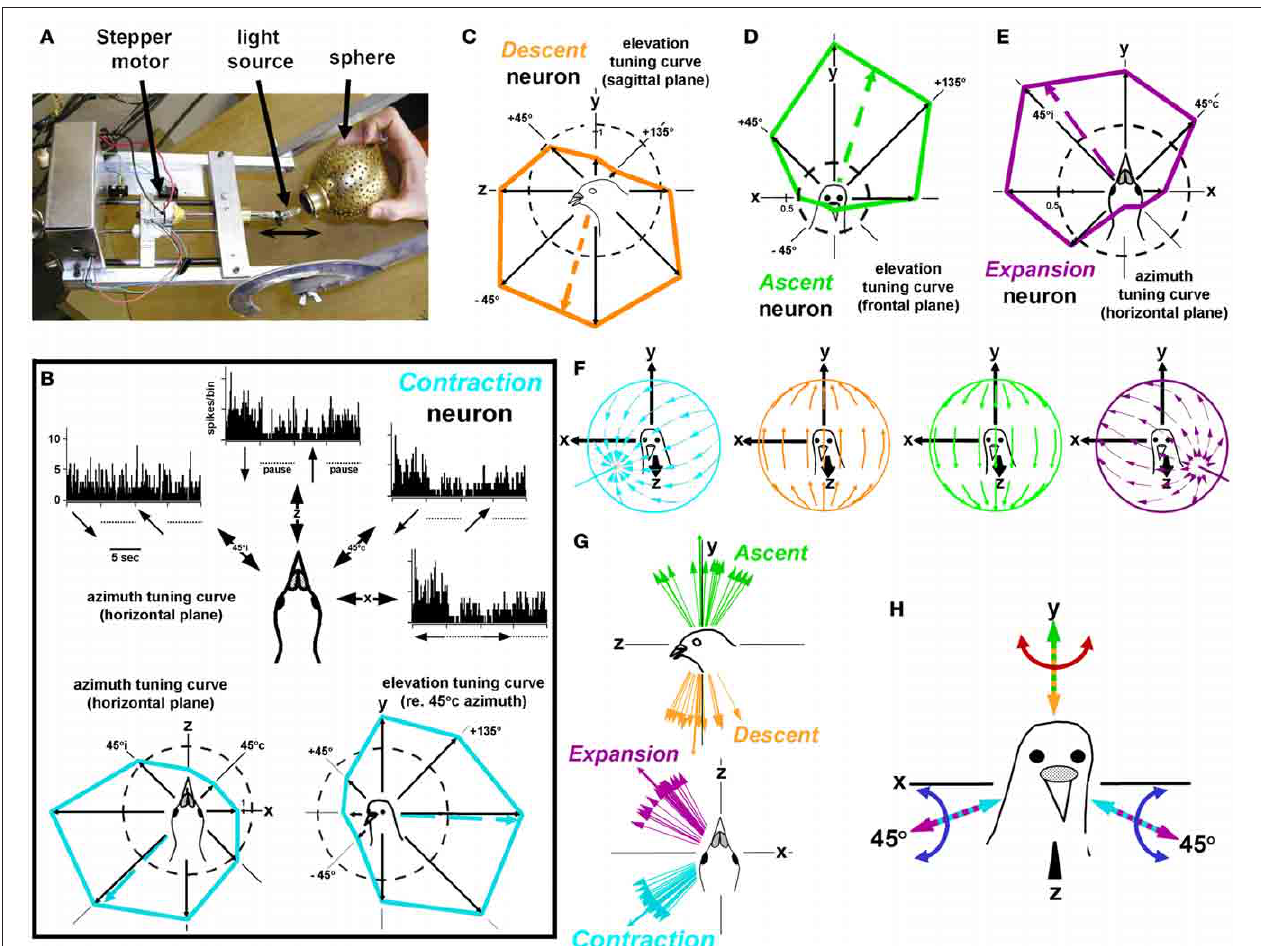
azimuth. (C–E) Show tuning curves for the other three types of translation neurons in the VbC: Descent , Ascent and Expansion . The flowfields that maximally stimulate each of the four types are shown in (F) , and the best axes of translation for the four groups are shown in (G) . (H) Shows the common reference frame for translational and rotational optic flow reponses in the VbC. The data are from Wylie and Frost (1999b). See text for additional